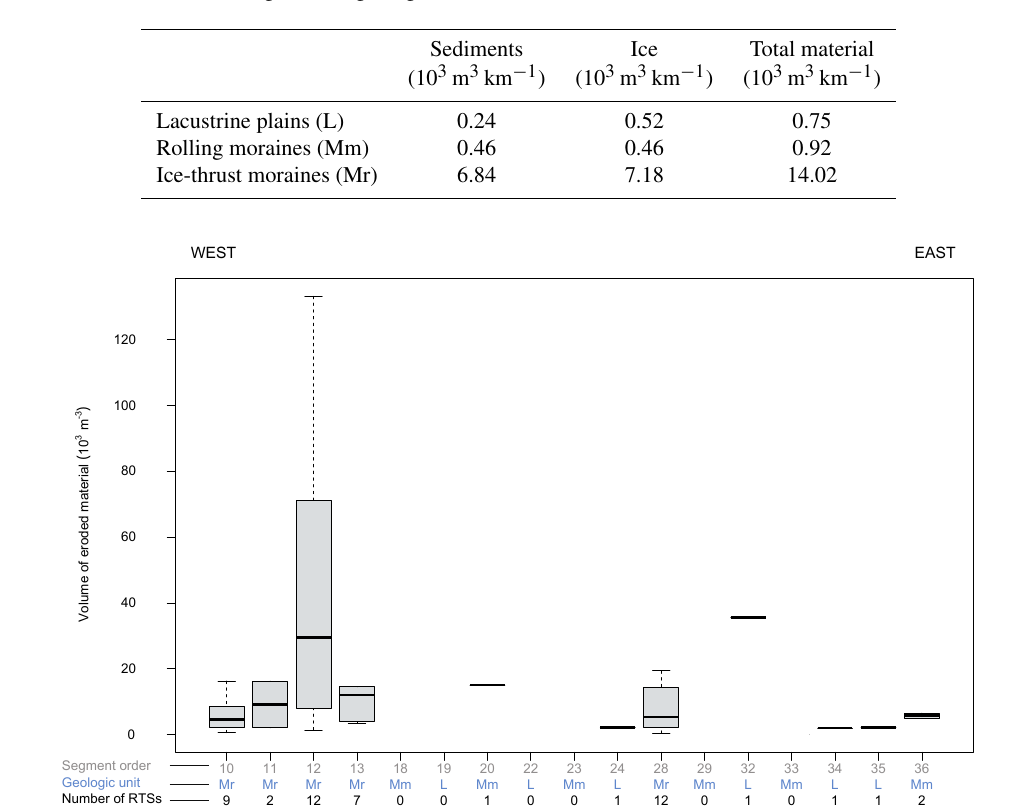
Table 2. Volume of material, including ice and sediments, eroded by RTSs initiated after 1972 along the Yukon Coast per geologic unit. The values are normalized to the shoreline length of the geologic units (km).